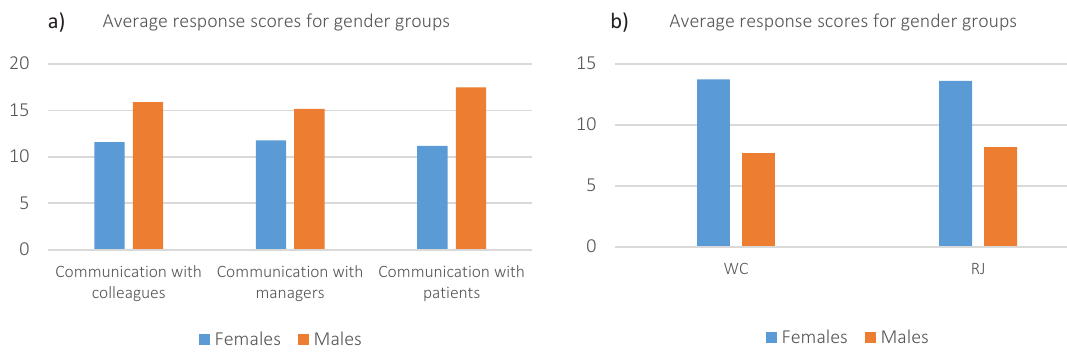
Figure 4. Significant differences between responses of gender groups on work conditions and motivation among mental health